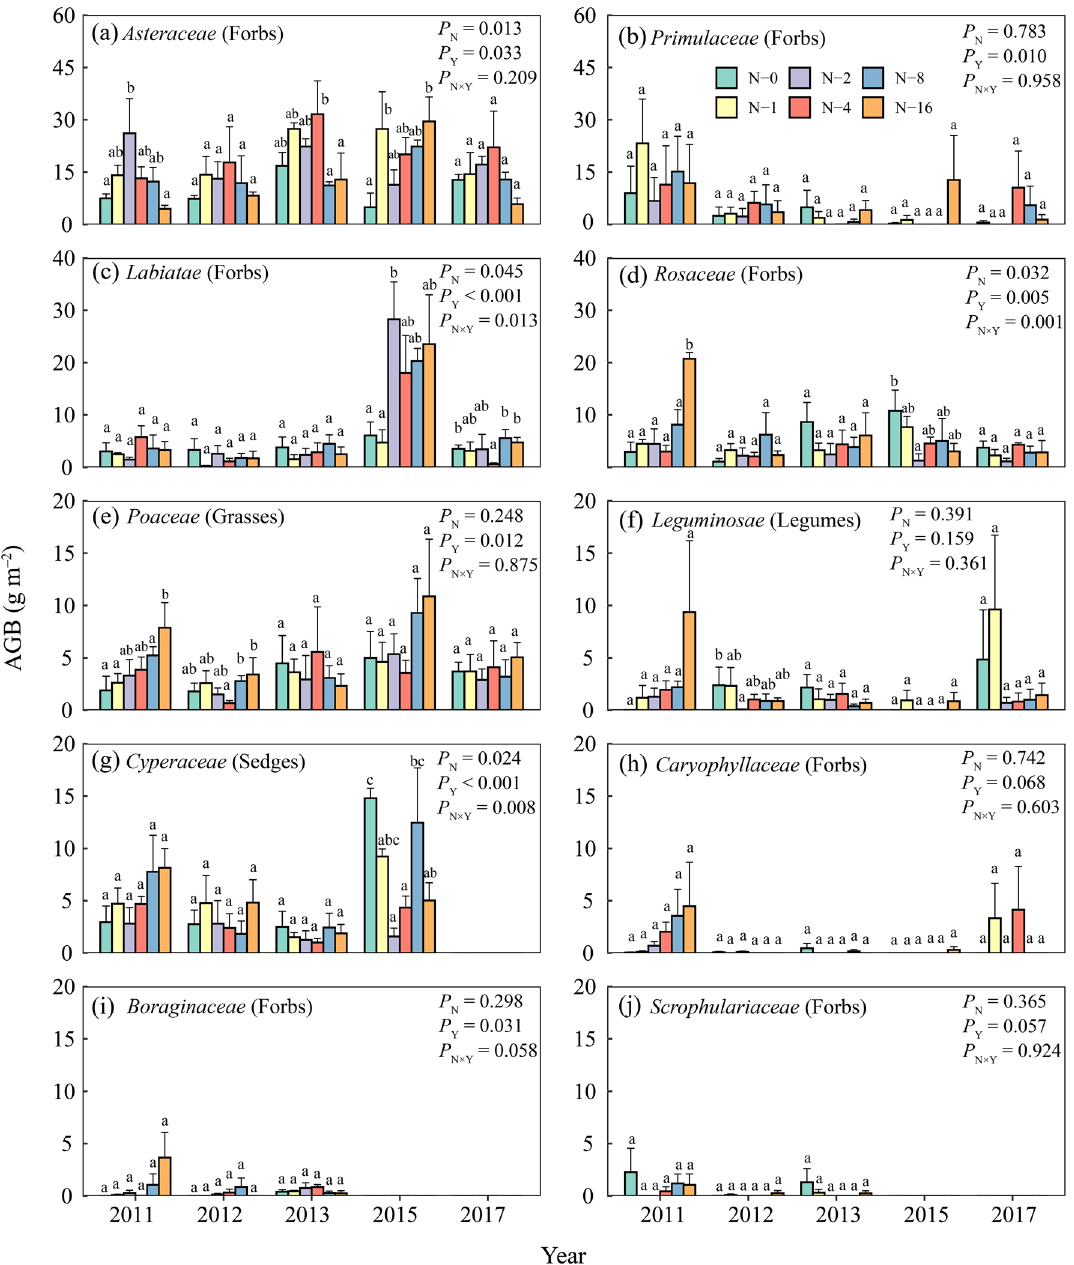
Figure 2. Aboveground biomass (AGB) of species from ten families in response to long term N addition rate. Biomass was collected from 2011 to 2013, 2015, and 2017 in Namco. Data are shown as mean ± SE ( n = 3). Bars with different letters indicate significant differences ( P < 0.05) by Duncan’s new multiple range test among fertilization levels. Full statistical results for two-way ANOVA (N, N fertilization; Y, year) are presented